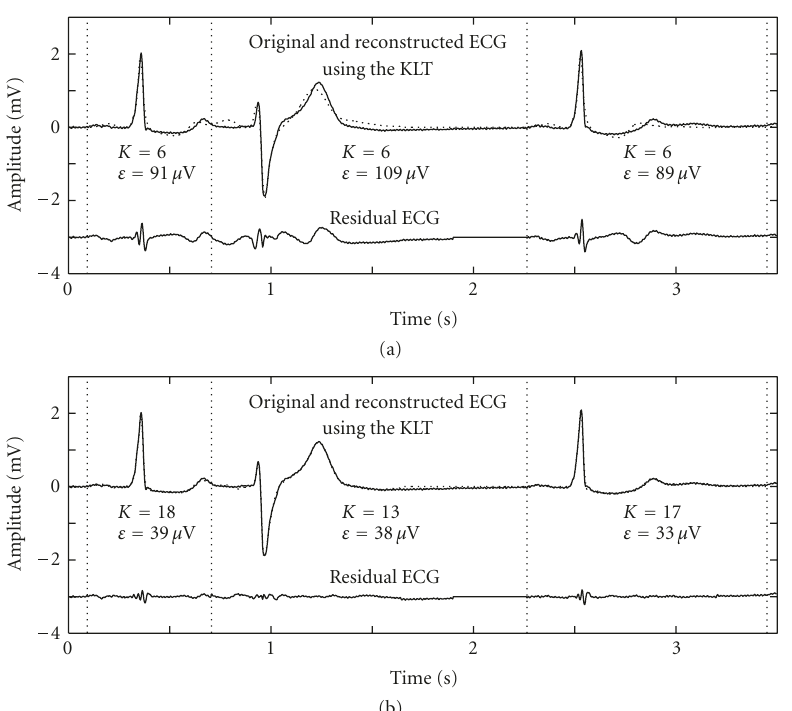
Figure 6: Quality control and KLT-based data compression. (a) A fixed number of basis functions ( K = 6) is used for signal reconstruction. (b) The number of basis functions is chosen so that the RMS error, denoted as ε , between the original and reconstructed signals is always below 40 μ V. For ease of interpretation, the residual ECG is plotted with a displacement of −